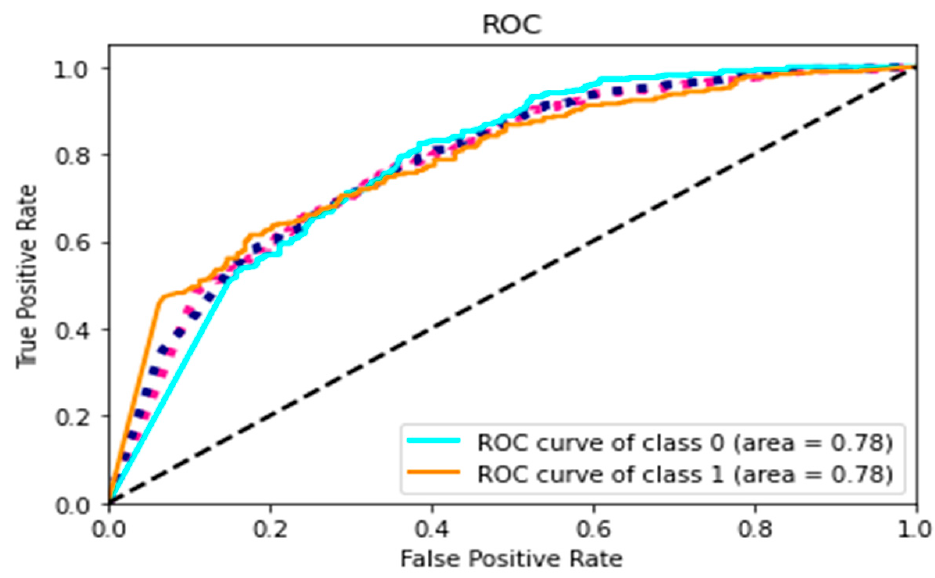
Figure 10. The ROC curve for binary classification using DeepBiLSTM. (Pink squares represent micro-average ROC curve, while purple squares represent the macro-average ROC curve).